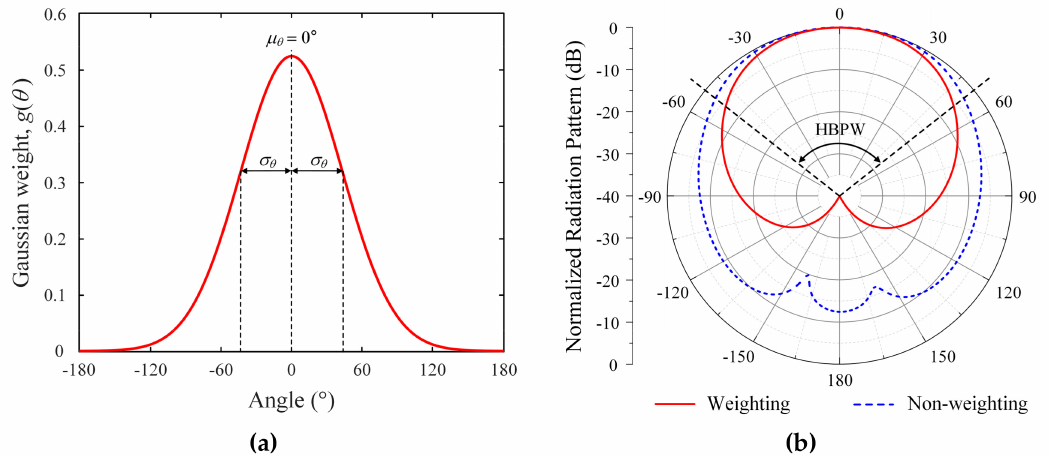
Figure 2. Gaussian weight and normalized radiation pattern when applying gaussian weight. ( a ) Gaussian function g ( θ ) where µ θ = 0 ◦ and σ θ = 43.5 ◦ . ( b ) Comparison of weighted and non-weighted radiation patterns of a microstrip patch